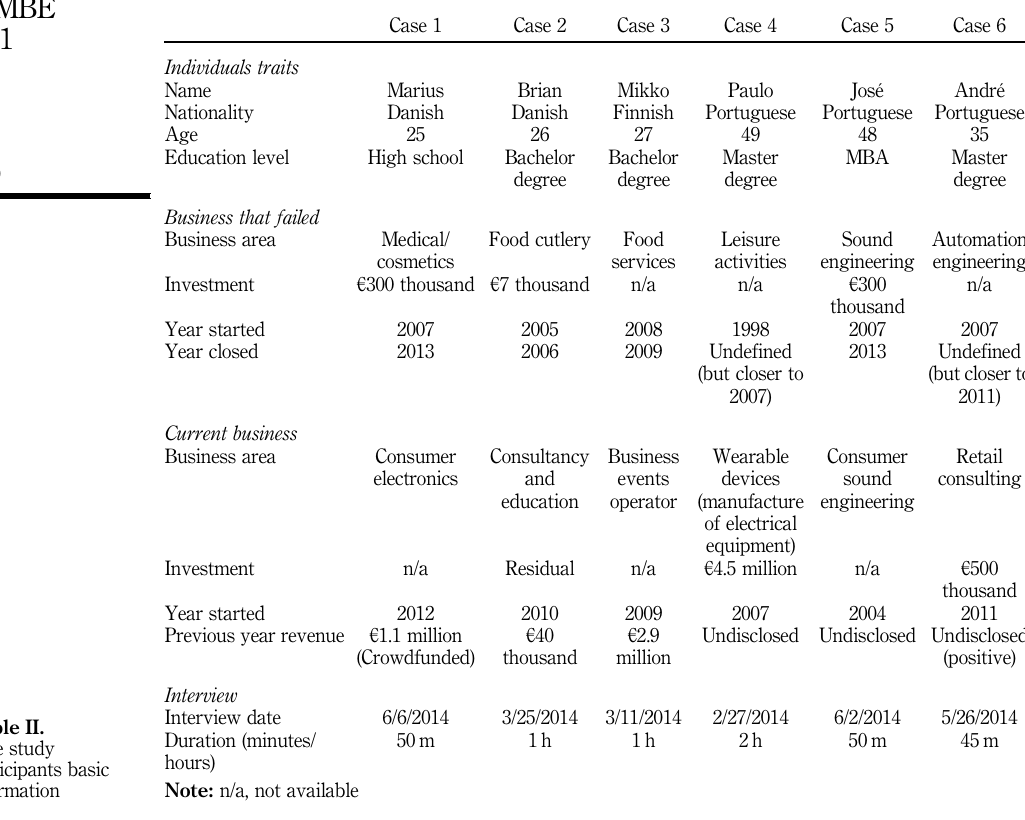
participants basic